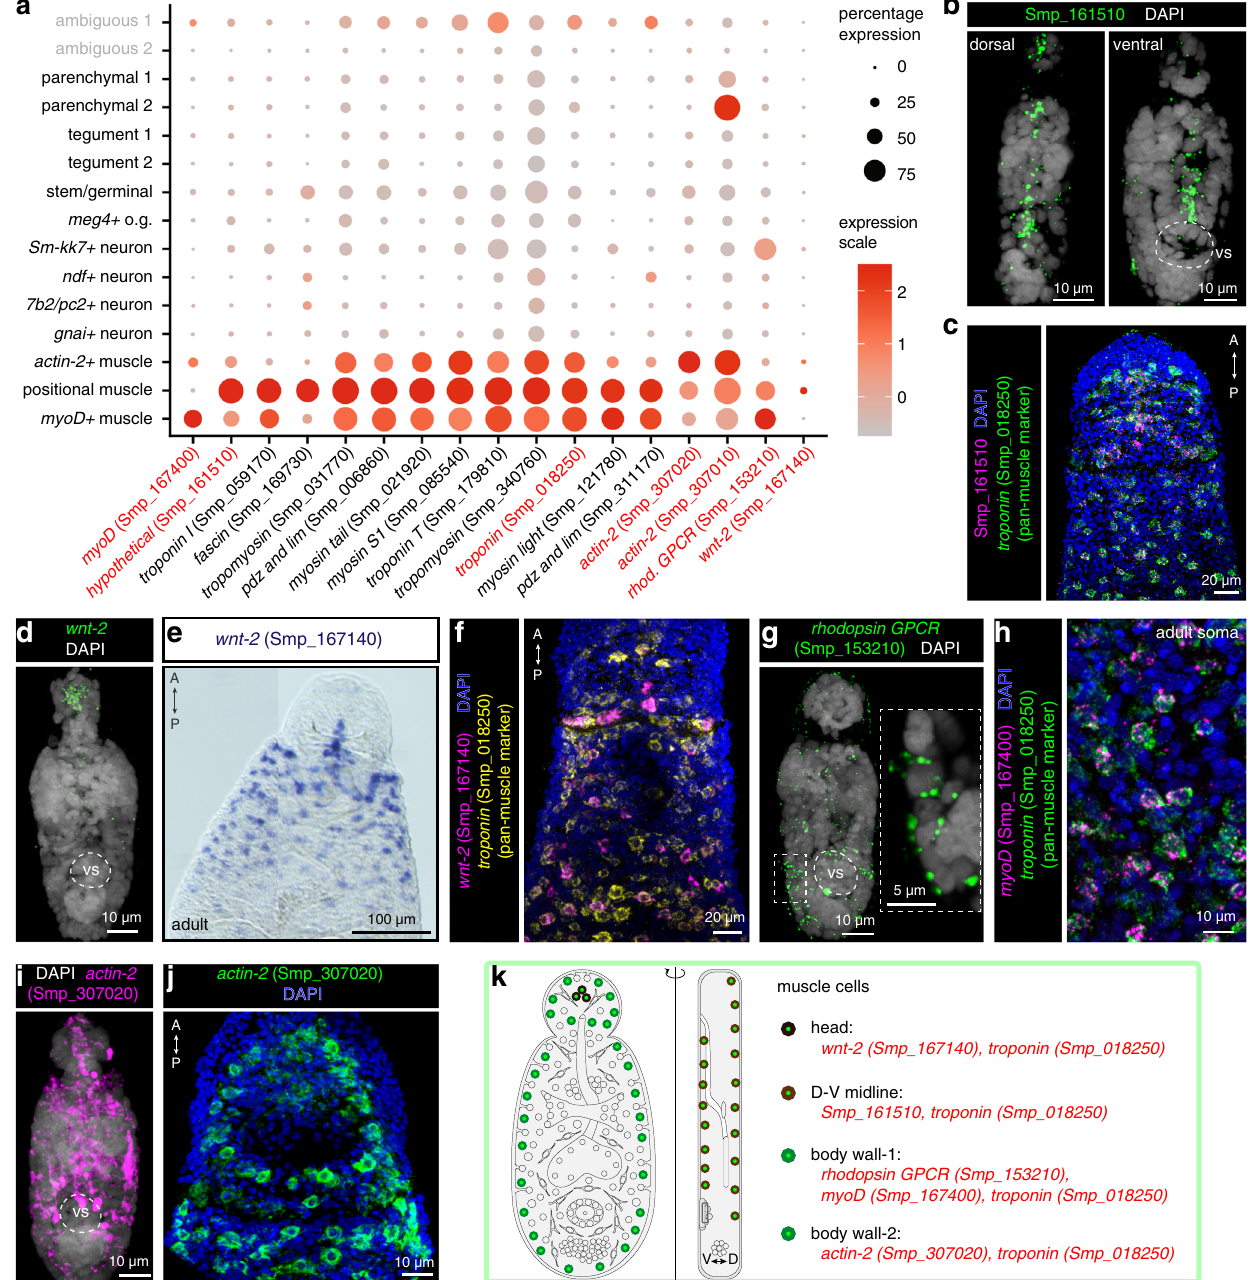
Fig. 2 Muscle cells express positional information underlying parasite development. a Expression pro fi les of cell markers that are speci fi c or enriched in the muscle clusters. Genes shown in red were validated by ISH. b FISH of Smp_161510. Smp_161510-expressing cells are found in dorsal and ventral sides along the midline. vs: ventral sucker. Single confocal sections shown for each image. c Double FISH of Smp_161510 and a pan-muscle marker troponin (Smp_018250) in the head region of the adult worm. A: anterior; P: posterior. Maximum intensity projection (MIP) is shown. d FISH of wnt-2 (Smp_167140) in 2-day old schistosomula, MIP. e Whole-mount in situ hybridisation (WISH) of wnt in the head region of the adult worm. The whole adult worm image is shown in Supplementary Fig. 4a. A: anterior; P: posterior. f Double FISH of wnt-2 (Smp_167140) and troponin (Smp_018250) in the head region of the adult worm, MIP. g FISH of rhodopsin GPCR (Smp_153210). Left: MIP; right: single magni fi ed confocal sections of the dotted box. h Double FISH of myoD (Smp_167400) and troponin (Smp_018250) in adult soma, MIP. i , j Spatial distribution of actin-2 (Smp_307020) throughout the body of the parasite. i schistosomulum, MIP; j adult male, MIP. k Schematic that summarises the muscle cell types in 2-day old schistosomula. Marker genes identi fi ed in the current study are indicated in red. V: ventral; D: dorsal. The numbers of ISH experiments performed for each gene are listed in ‘ Methods ’ and Supplementary Data